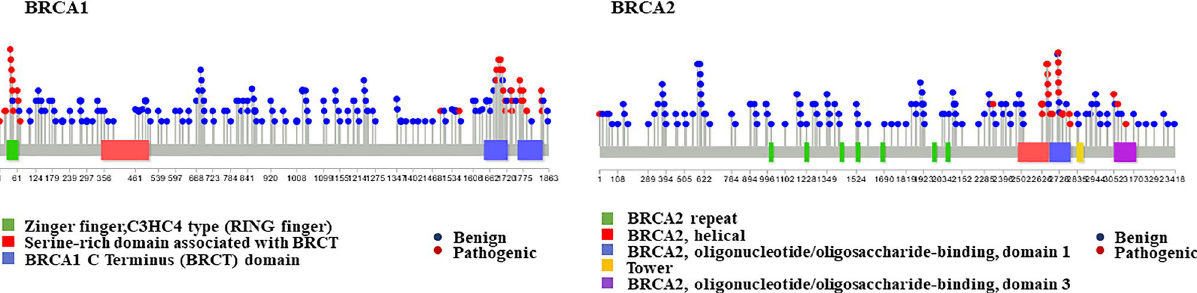
Figure 1. The distributions of BRCA1 and BRCA2 missense variants shown as lollipop plots. Benign and likely benign variants are represented by blue circles and red circles depict pathogenic and likely pathogenic